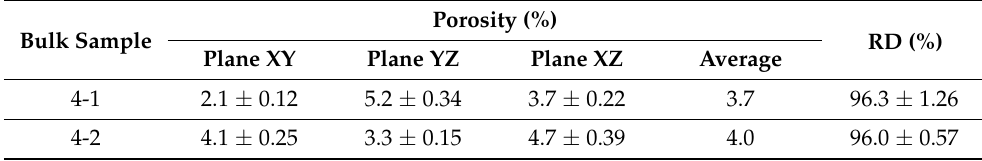
Table 4. Porosity measured in different planes and relative density.